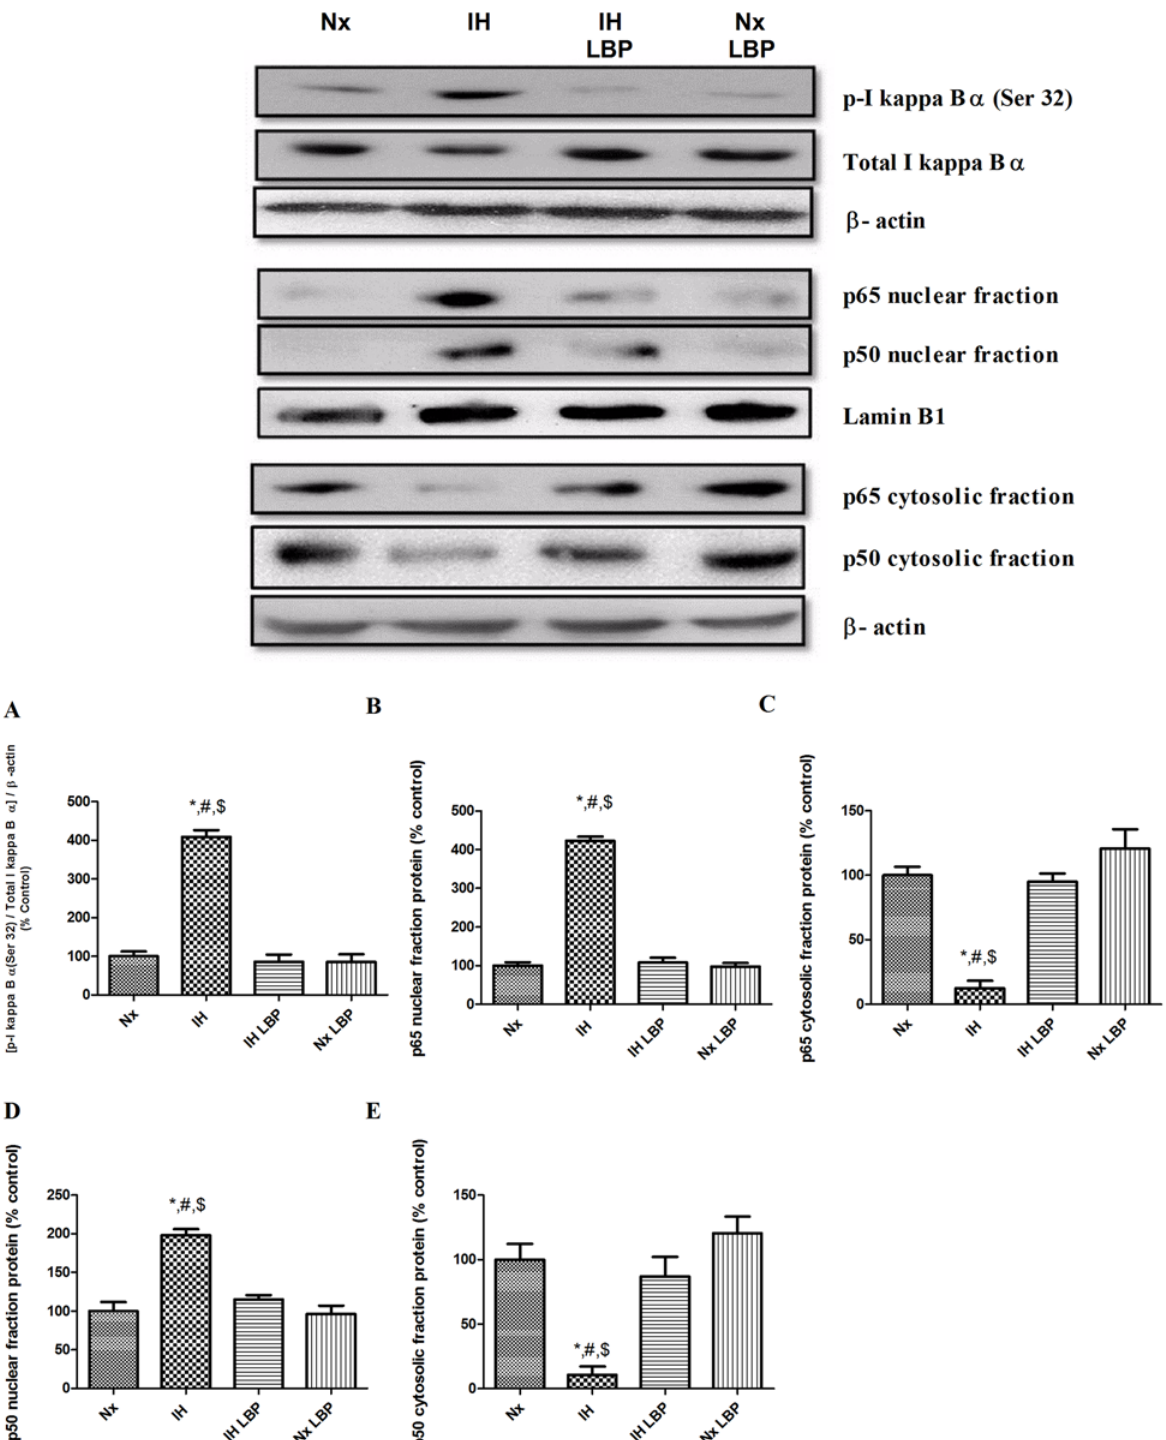
Fig 6. LBP ameliorated CIH-induced inflammation by inhibiting the degradation of redox-sensitive NF К B canonical pathway negative regulator I К B and by suppressing the translocation of NF К B member p65 and p50 from cytosol to nucleus. Levels of (A) phosphorylation of I К B α , nuclear protein expression of (B) p65, (C) cytosolic protein expression of (C) p65, nuclear protein expression of (D) p50, and cytosolic protein expression of (E) p50 in the hippocampus (upper panel) of the normoxic (Nx) or hypoxic (IH) groups; LBP-treated hypoxic (IH+LBP) or normoxic (Nx+LBP) groups are summarized. Lamin B1 was an internal control of the nuclear fraction, whereas β -actin was an internal control of the cytosolic fraction and whole cell lysate. Data are mean ± SEM (n = 6 – 8). * p < 0.05 when compared with Nx, # p < 0.05 when compared with IH+LBP, $ p < 0.05 when compared with Nx+LBP groups.